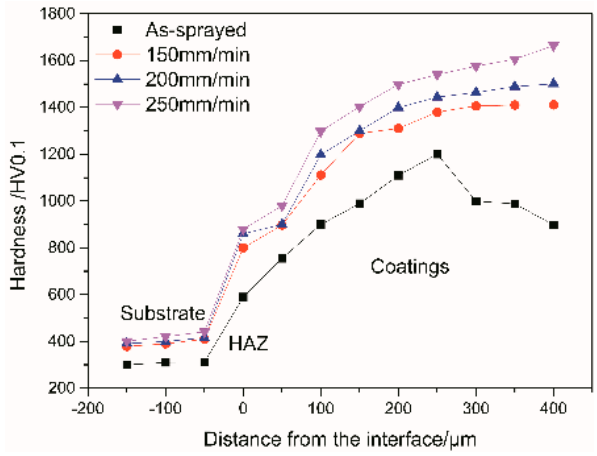
Figure 11. Micro-hardness changes through the cross-section.